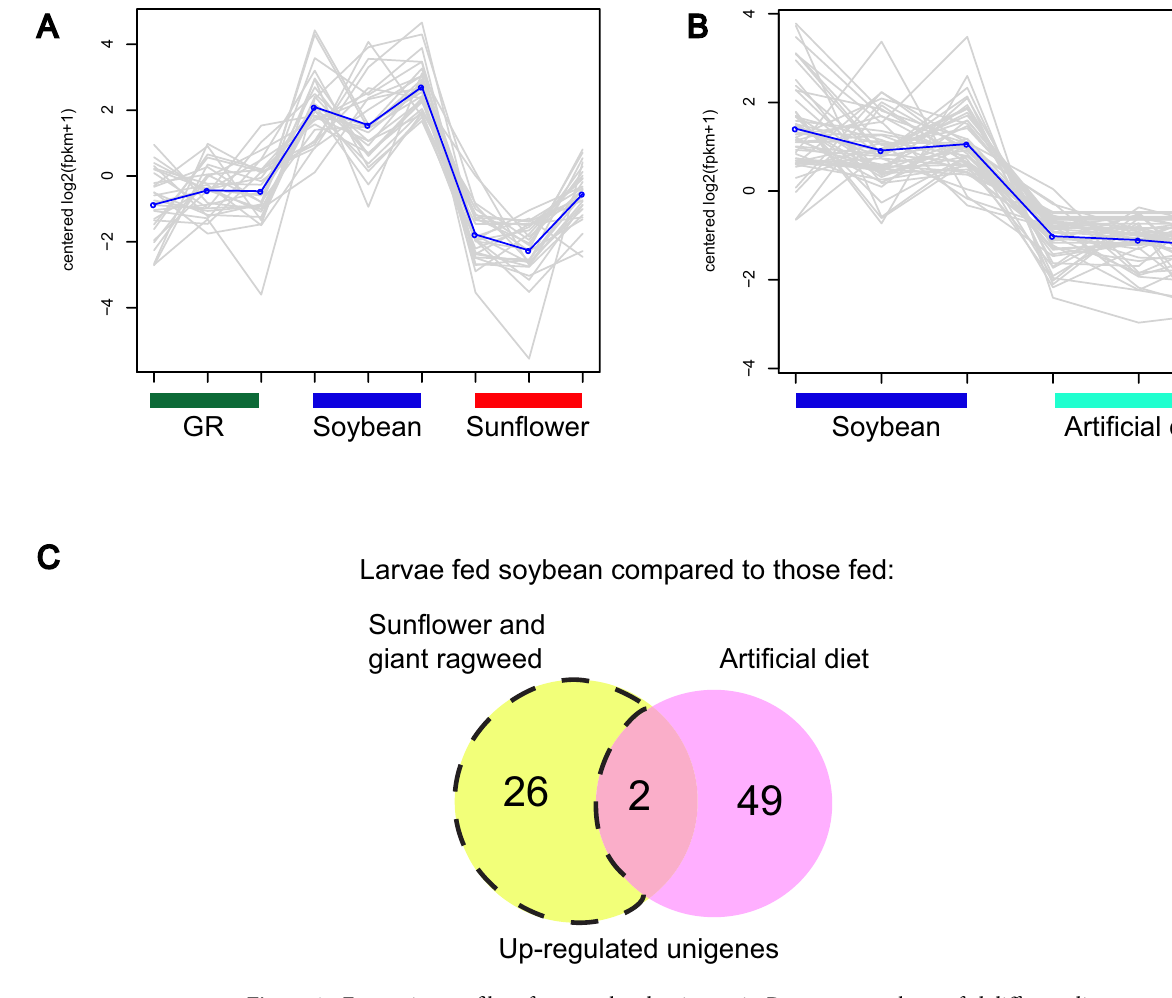
Figure 4. Expression profiles of up-regulated unigenes in Dectes texanus larvae fed different diet treatments ( A ) Unigenes with higher expression levels in larvae fed soybean compared to those fed sunflower and giant ragweed ( B ) Unigenes with higher expression levels in larvae fed soybean compared to those fed artificial diet and ( C ) Venn diagram of upregulated unigenes in larvae fed soybean compared to those fed sunflower, giant ragweed, and artificial diet. Clusters were constructed with differentially expressed genes showing similar expression patterns across all treatments (Fold change > ± 1.5, False Discovery Rate < 0.05). GR = Giant